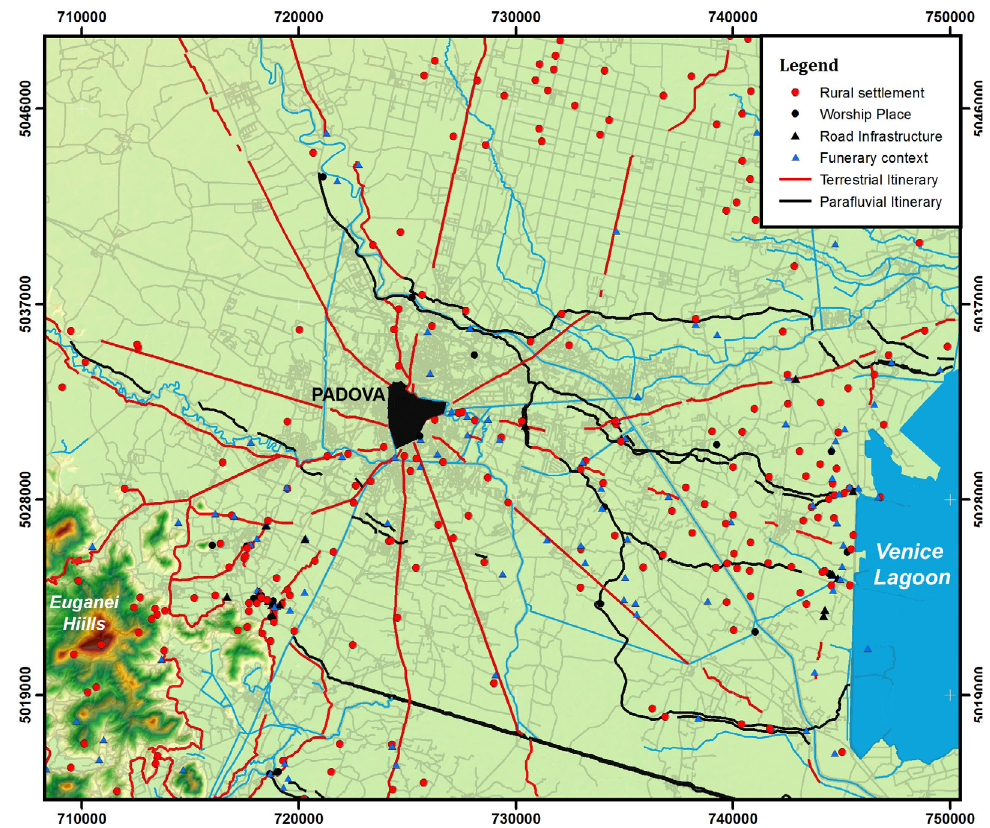
Fig. 3 Results of the archaeomorphological analysis: the Roman road network around Padua. Grey lines represent the contem- porary road network, while blue lines correspond to the present-day river network.